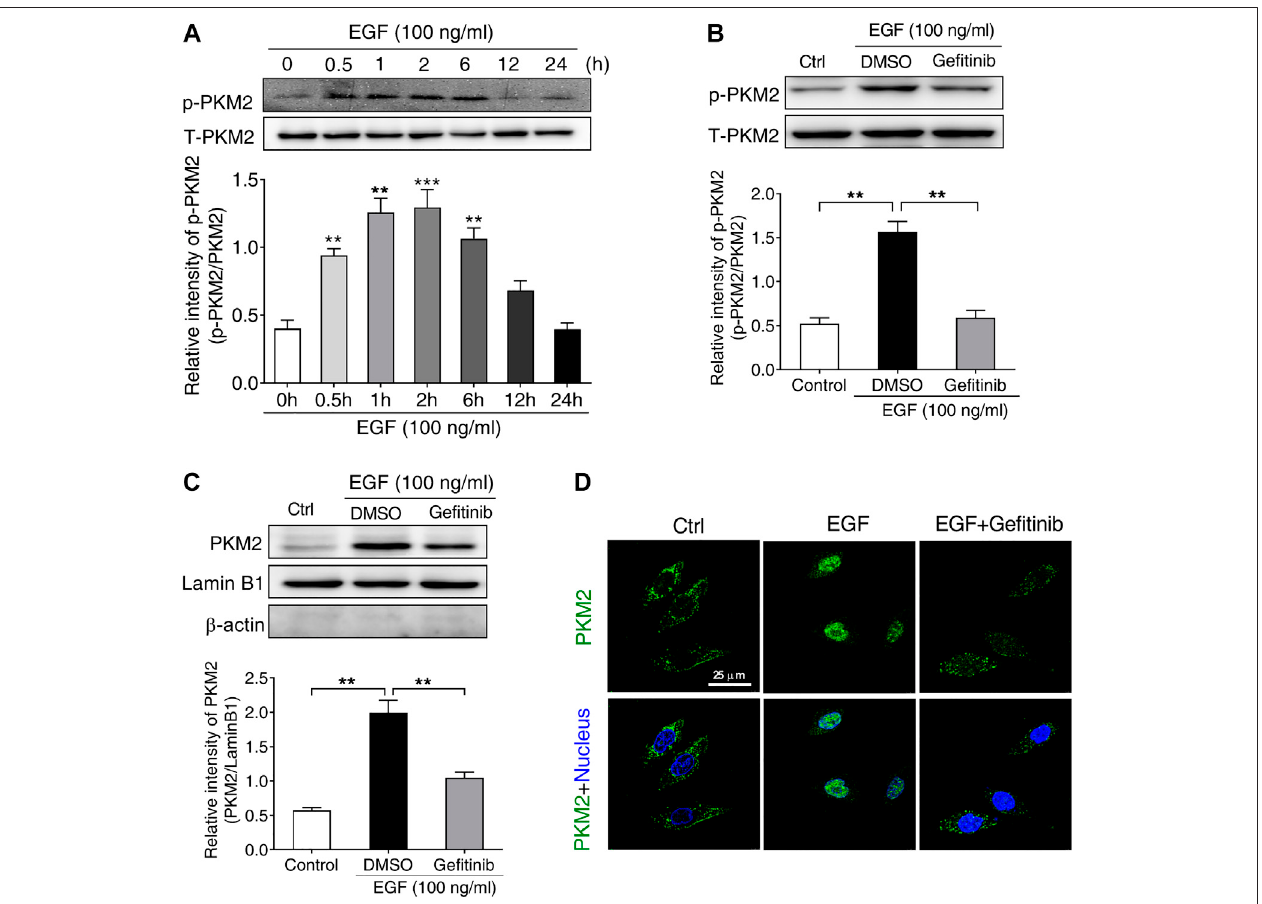
FIGURE 3 | EGF stimulates the phosphorylation and nuclear translocation of PKM2 in SNU-368 cells (A) EGF induced an increase in the level of PKM2 Ser 37 phosphorylation in SNU-368 cells. **p < 0.01, ***p < 0.001, one-way ANOVA, n (cid:2) 6 per group (B) Ge fi tinib attenuated EGF-induced the level of PKM2 Ser 37 phosphorylation in SNU-368 cells. **p < 0.01, one-way ANOVA, n (cid:2) 5 per group (C) EGF-mediated PKM2 nuclear accmulation was reversed by Ge fi tinib in SNU-368 cells. Lamin B1 was used as internal control and β -actin was used as negative control. **p < 0.01, one-way ANOVA, n (cid:2) 5 per group (D) Immuno fl uorescence staining showed Ge fi tinib attenuated EGF-induced PKM2 nuclear accmulation in SNU-368 cells.